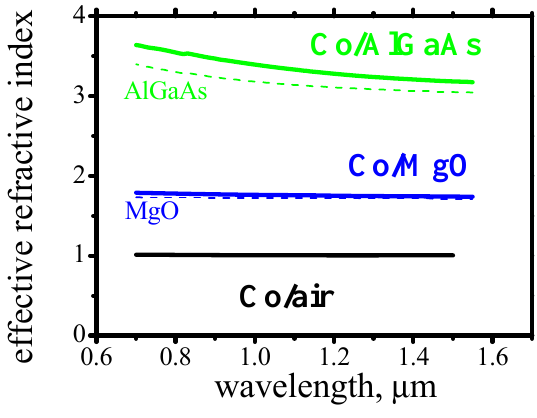
Figure 3. Effective refractive indexes of surface plasmons propagating along Co/Al Ga As, Co/MgO and Co/air interfaces (solid lines) and refractive index of 0.5 0.5 Al Ga As and MgO (dashed lines). 0.5 0.5